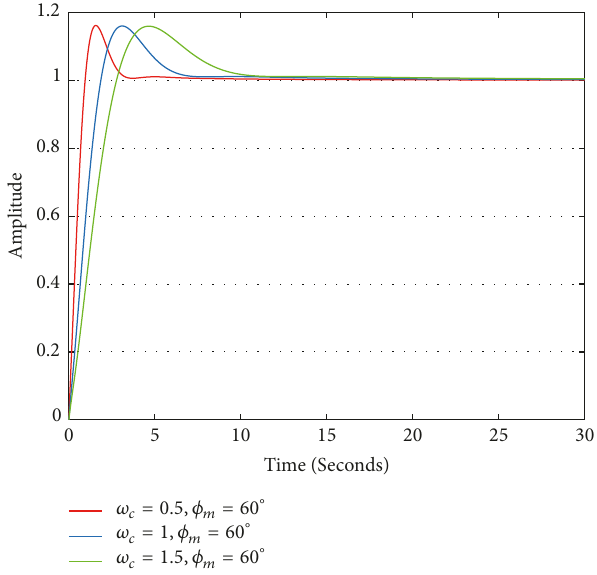
Figure 11: Step responses of 𝑃 1 (𝑠) with different 𝜔 𝑐 .